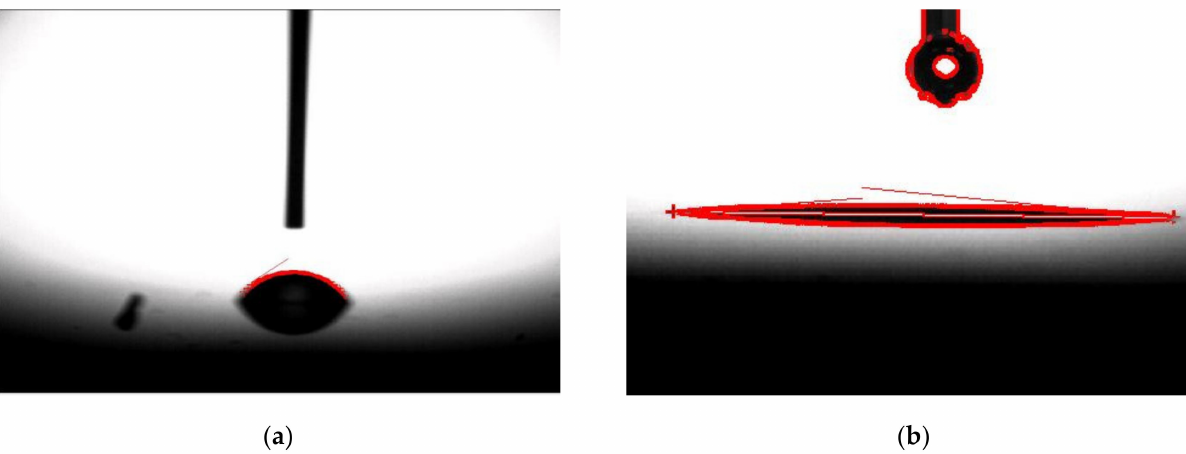
Figure 6. CA measurement: ( a ) Contact angle before activation; ( b ) Contact angle after